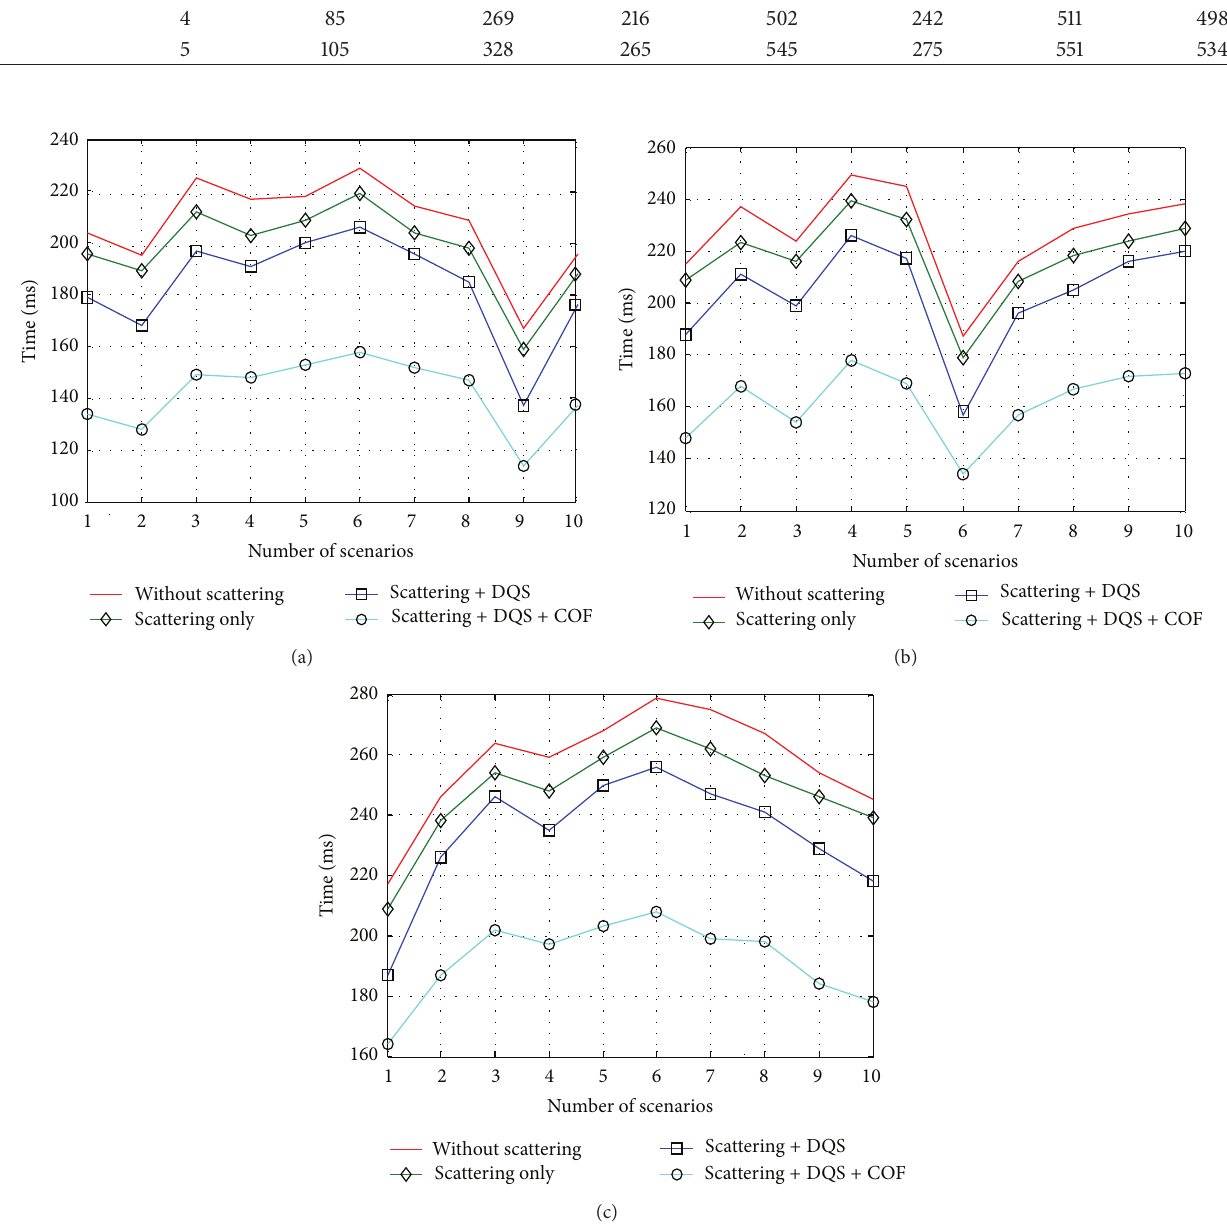
Figure 11: Effects of scattering and the proposed optimization techniques on time for (a) SF = 4 , (b) SF = 8 , and (c) SF = 20